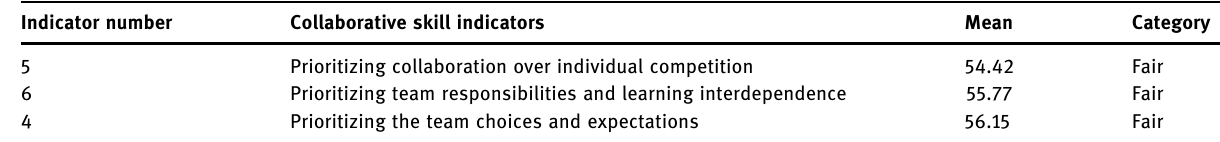
Table 9: Summary of three lowest collaborative skill indicators from descriptive analysis result Indicator